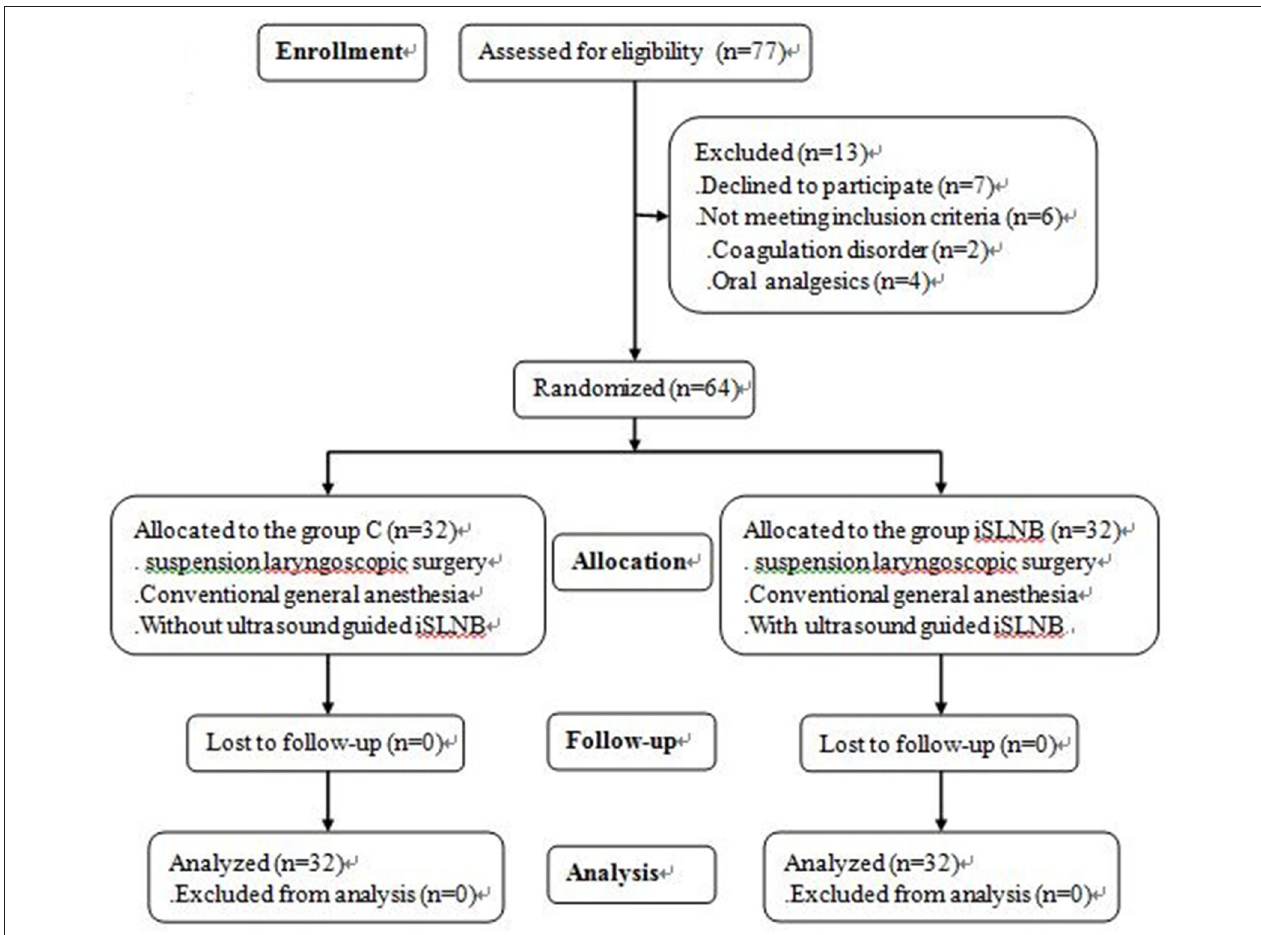
FIGURE 1 | CONSORT flow diagram of this study iSLNB: internal branch of superior laryngeal nerve block.